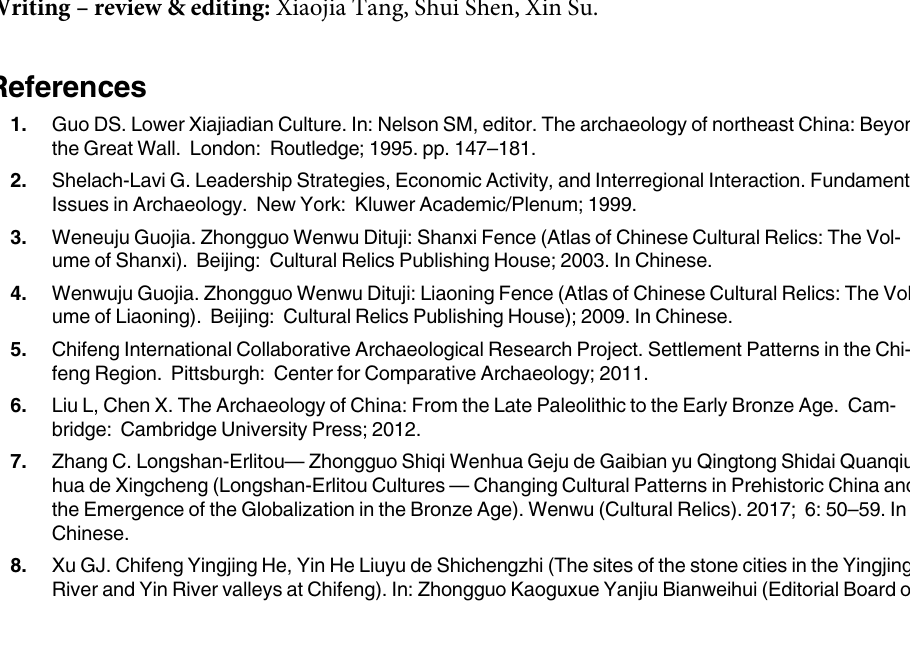
S1 Table. Radiocarbon dates for the Lower Xiajiadian